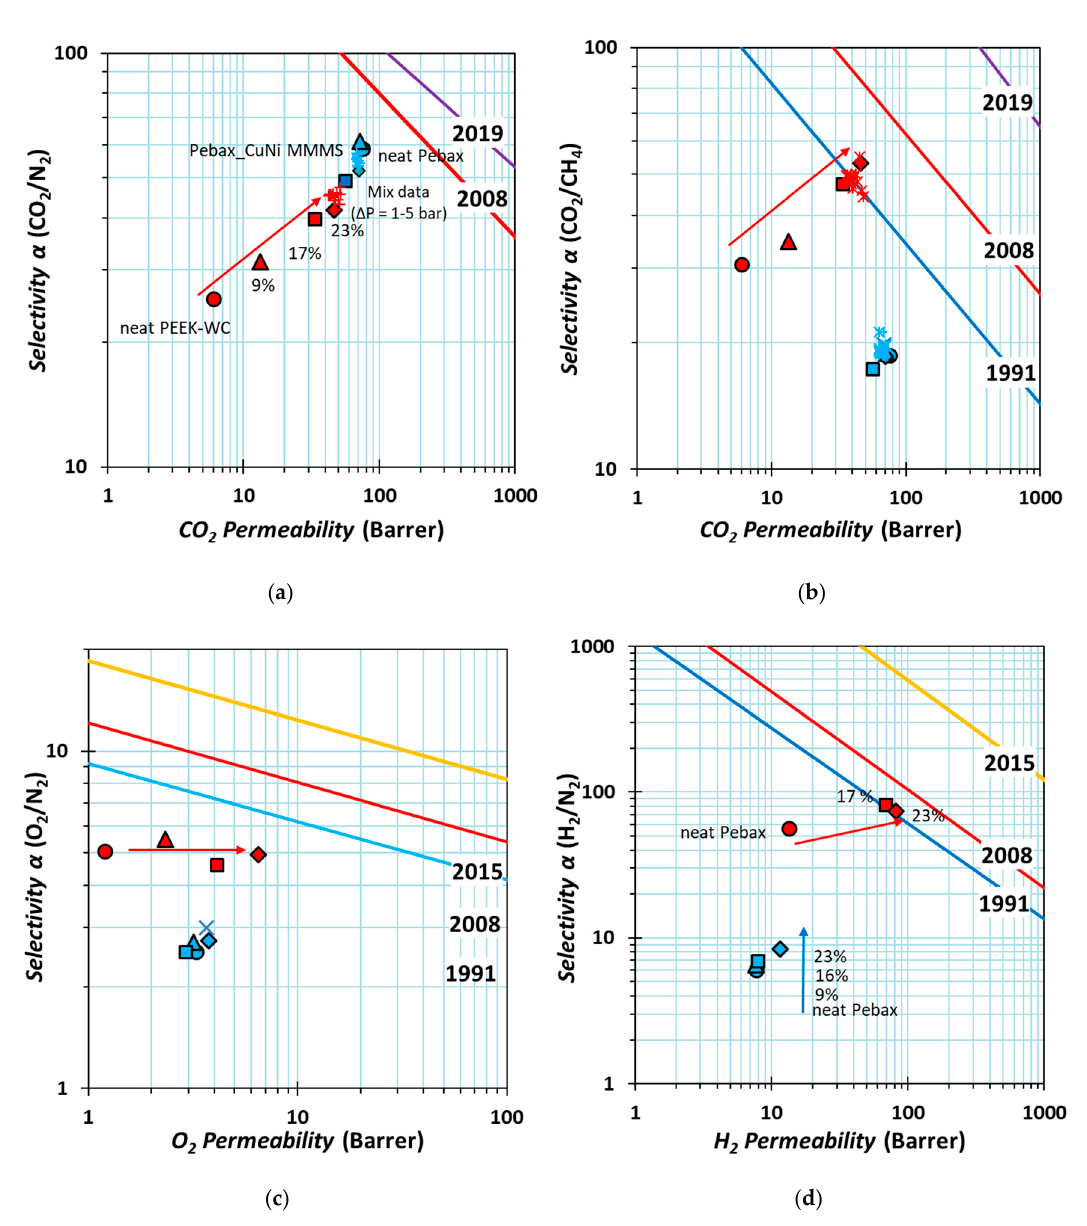
Figure 9. Robeson’s plots for CO 2 /N 2 ( a ) CO 2 /CH 4 ( b ) O 2 /N 2 ( c ) H 2 /N 2 ( d ) showing the data of Pebax1657/CuNi (blue) and PEEK-WC/CuNi at different MOF loadings of 0 wt % (= neat polymers, • , • ), 9 wt % ( ▲ , ▲ ),17 wt % ( ■ , ■ ) and 23 wt % ( ♦ , ♦ ). Blue line 1991 upper bound, red line 2008 upper bound [8,9]; yellow line 2015 [60]; purple line 2019 upper bound [61]. The arrows qualitatively indicate the direction of increasing MOF loading. The clouds of blue “X” and red “X” symbols represent the mixed gas data in the pressure range of 1–6 bar for Pebax1657/CuNi-MOF at 29 wt % and PEEK-WC/CuNi-MOF at 23 wt % of MOF loading. Please refer to the electronic version for colour figures.